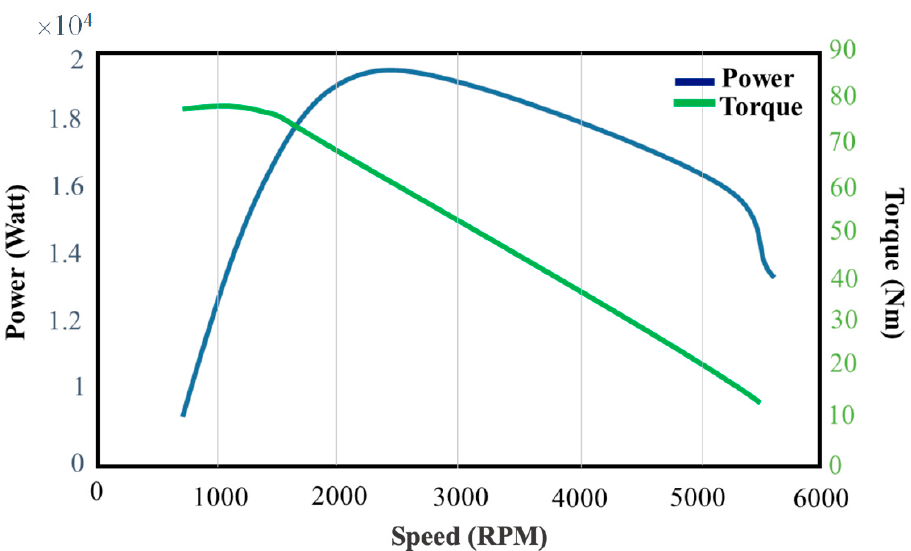
Figure 18. The experimental test results of the IPMSM and its controller using an eddy current dy- namometer.